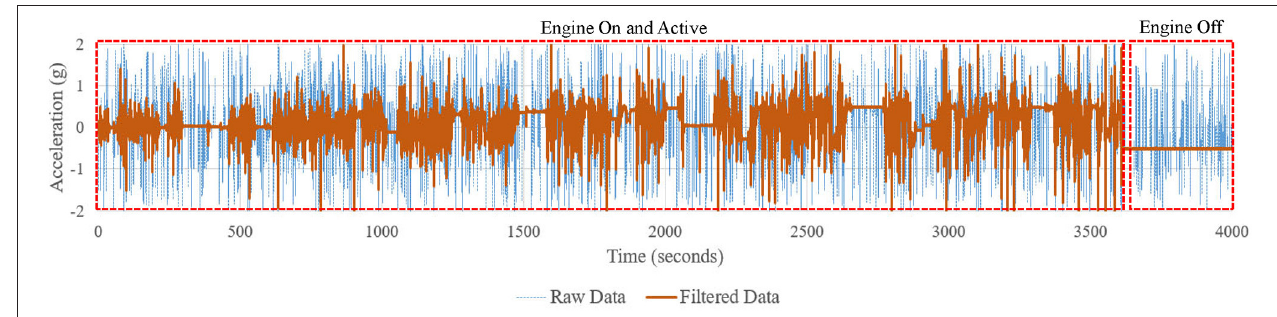
FIGURE 3 | Raw and filtered IMU